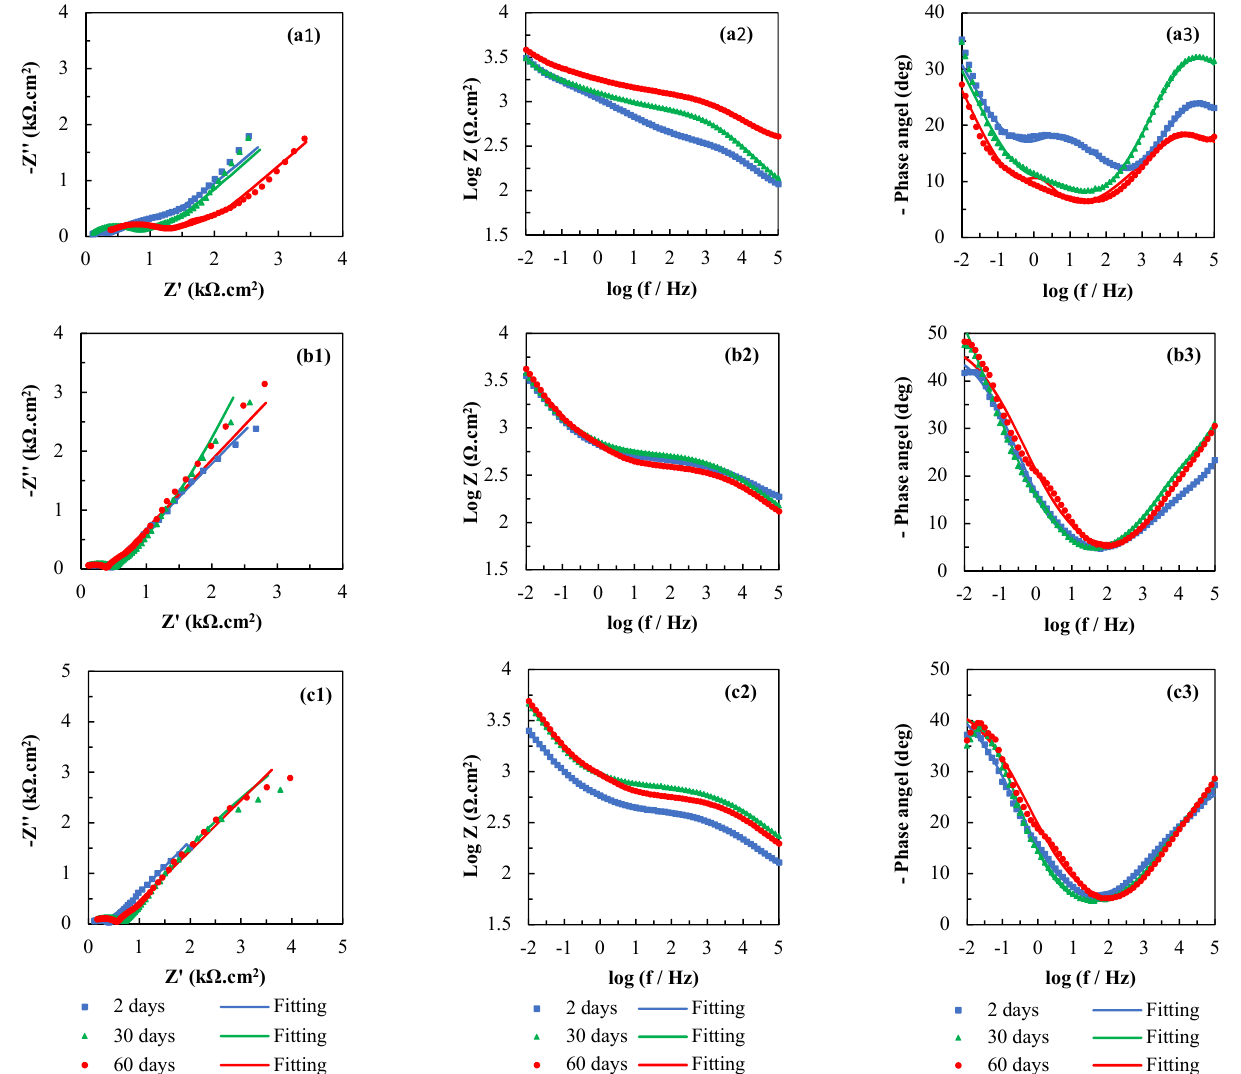
Figure 2. Nyquist (series 1) and Bode (series 2 and 3) plots with different pigments of silicate coating (series ( a ): FZnAl20; series ( b ): FZnAl25; series ( c ): FZnAl30) at various immersion times of 2 days, 30 days, and 60 days in 3.5 wt% NaCl.